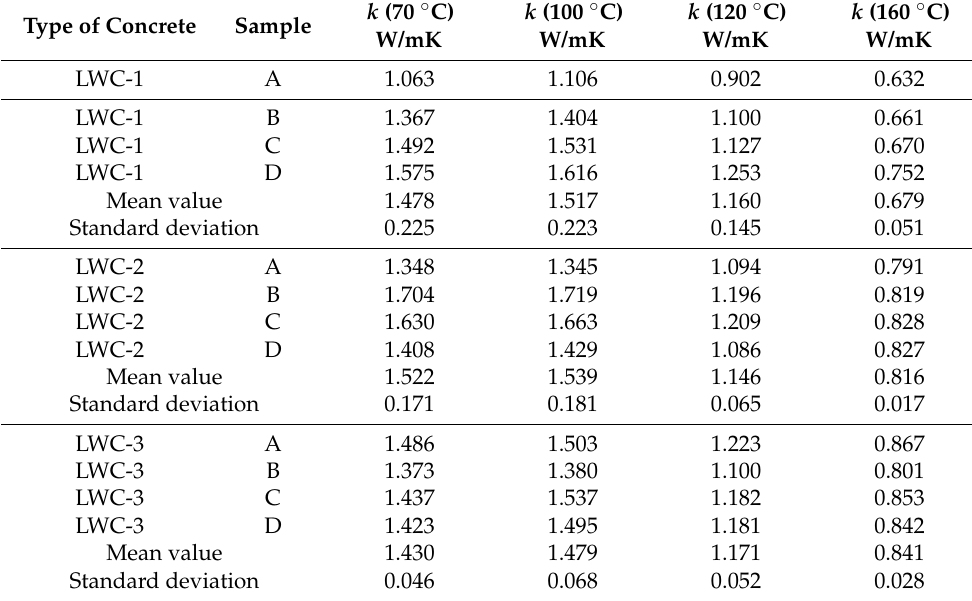
Table 5. Average thermal conductivity values of LWC samples in different high-temperature environments. Type of